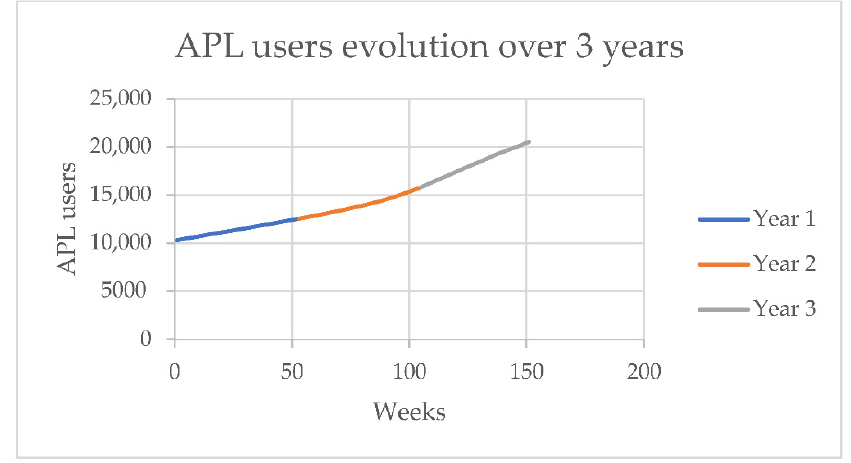
Figure 4. APL users evolution over 3 years.